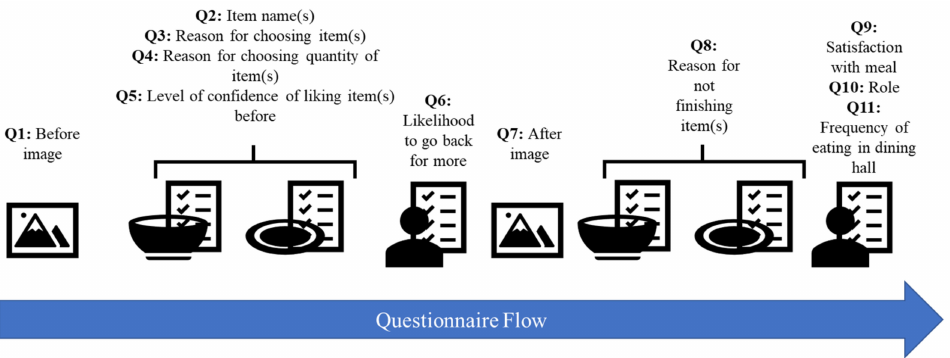
Figure 1. Questions and question type—photo, per dish, per individual—that were asked in this